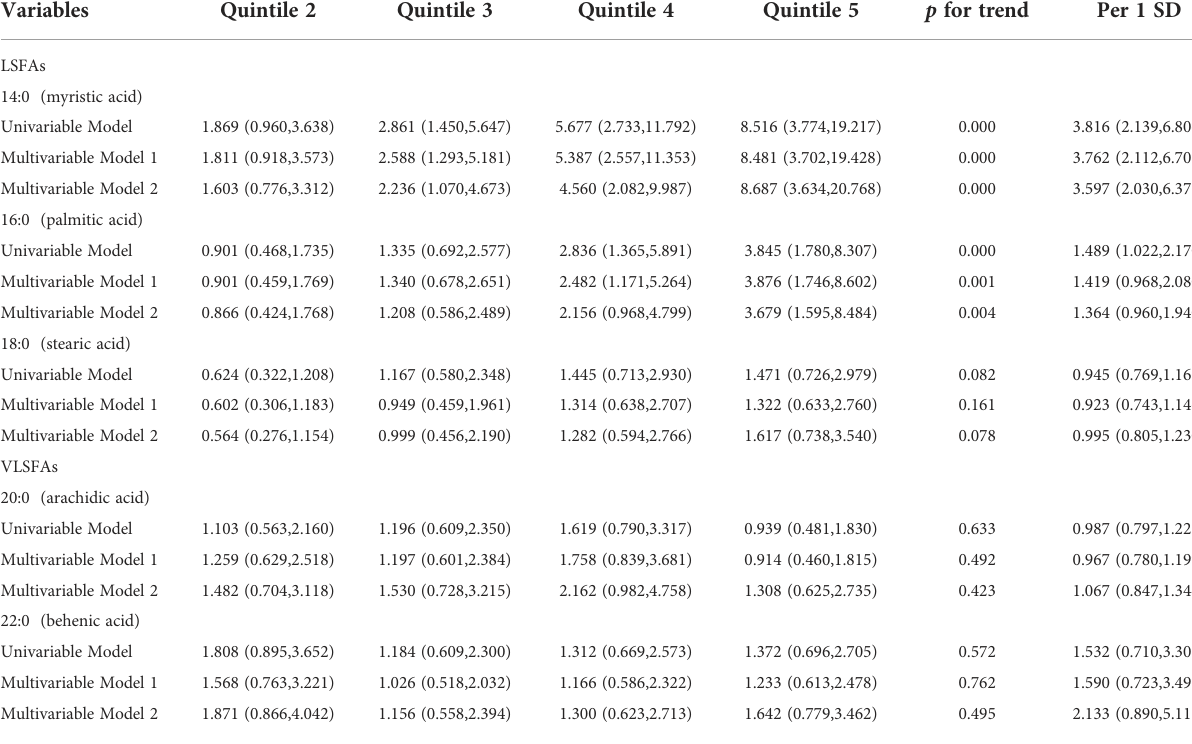
TABLE 4 Odds ratios (and 95% CIs) for nonalcoholic fatty liver disease by quintile of saturated fatty acids after exclusion of patients with a history of alcohol